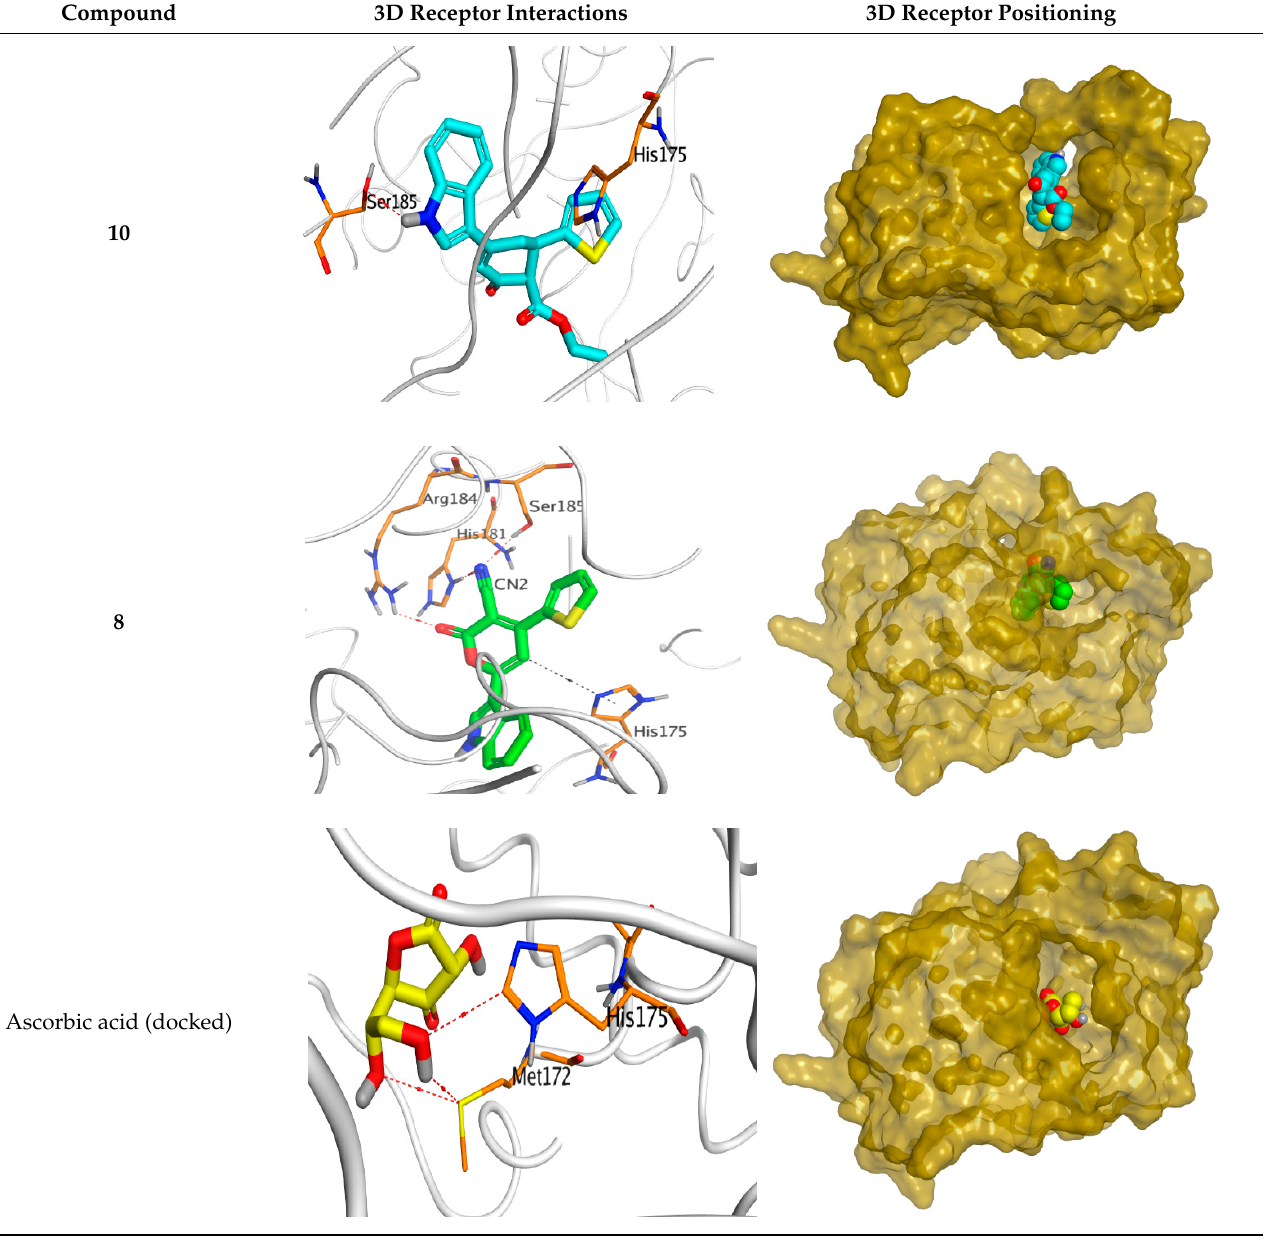
Table 3. 3D receptor interactions and positioning of the two most promising compounds ( 10 and 8 ) compared to the docked ascorbic acid as a reference standard inside the binding pocket of cytochrome c peroxidase. Compound